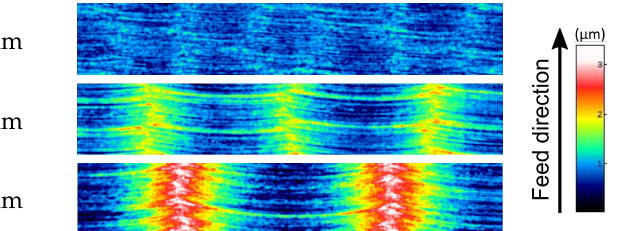
Figure 10. Surface parts with dimensions of 0.2 mm × 1.2 mm from the measured surface topogra- phies of samples made of titanium alloy Ti Gr 5 after milling with feed f t = 0.06 mm and different values of cutting width b r